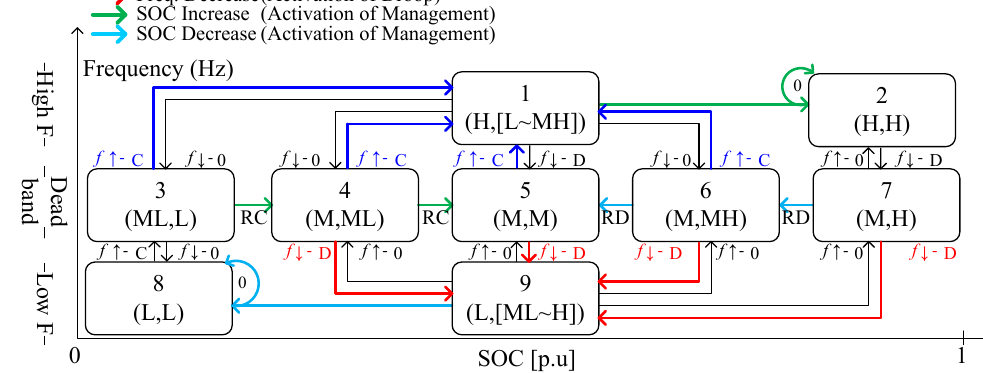
Figure 6. State machine showing influential factors and state transition.